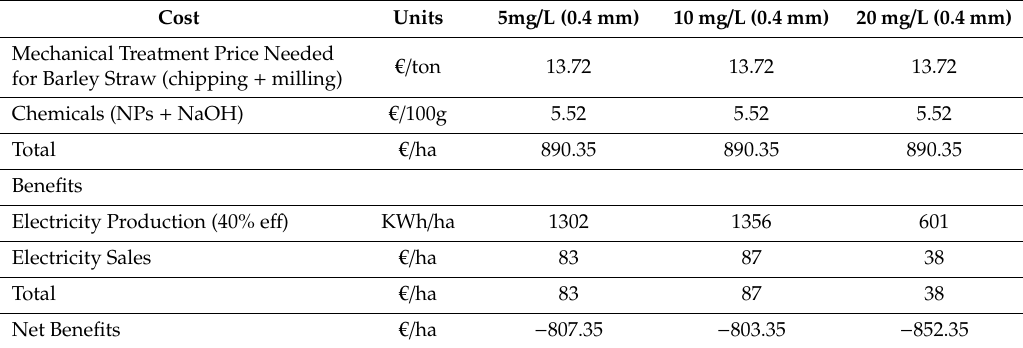
Table 9. Cost-benefit for barley straw with combined mechanical and chemical